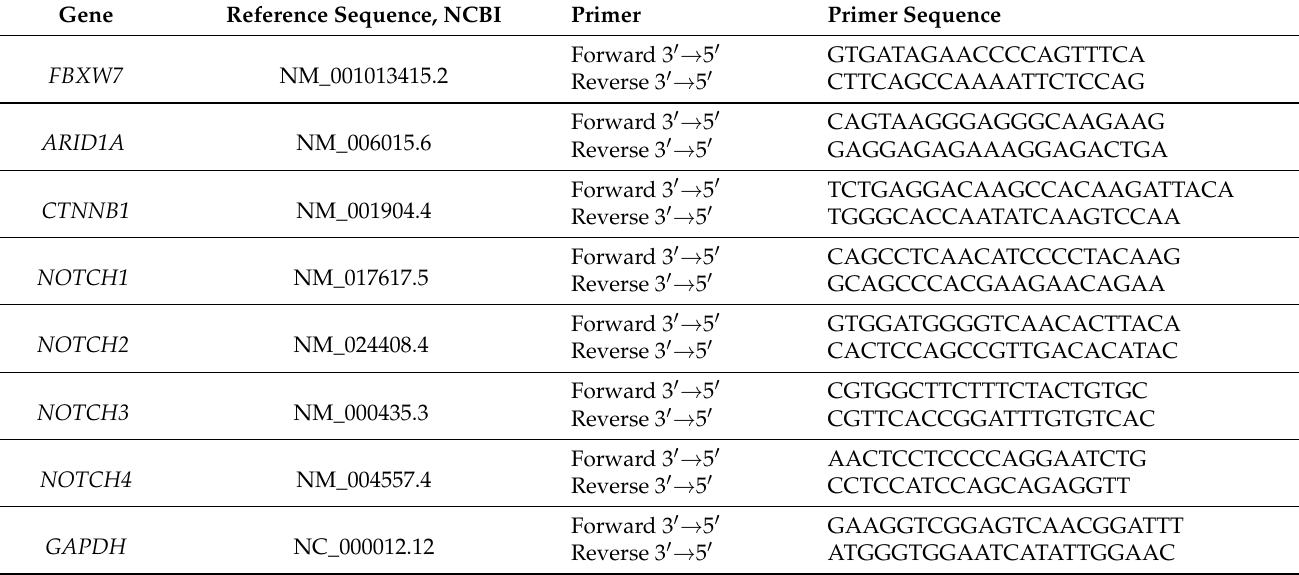
Table A1. Primer pairs used in the